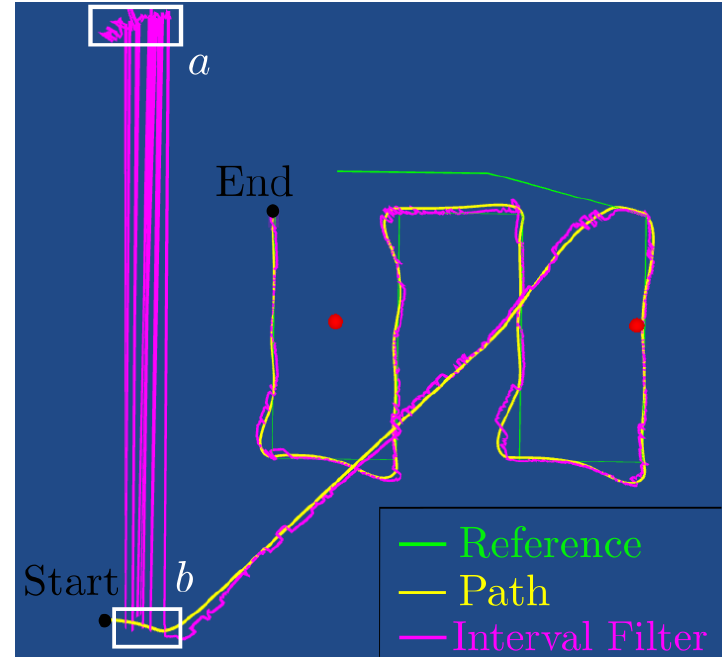
Figure 7. Scenario 2 with interval